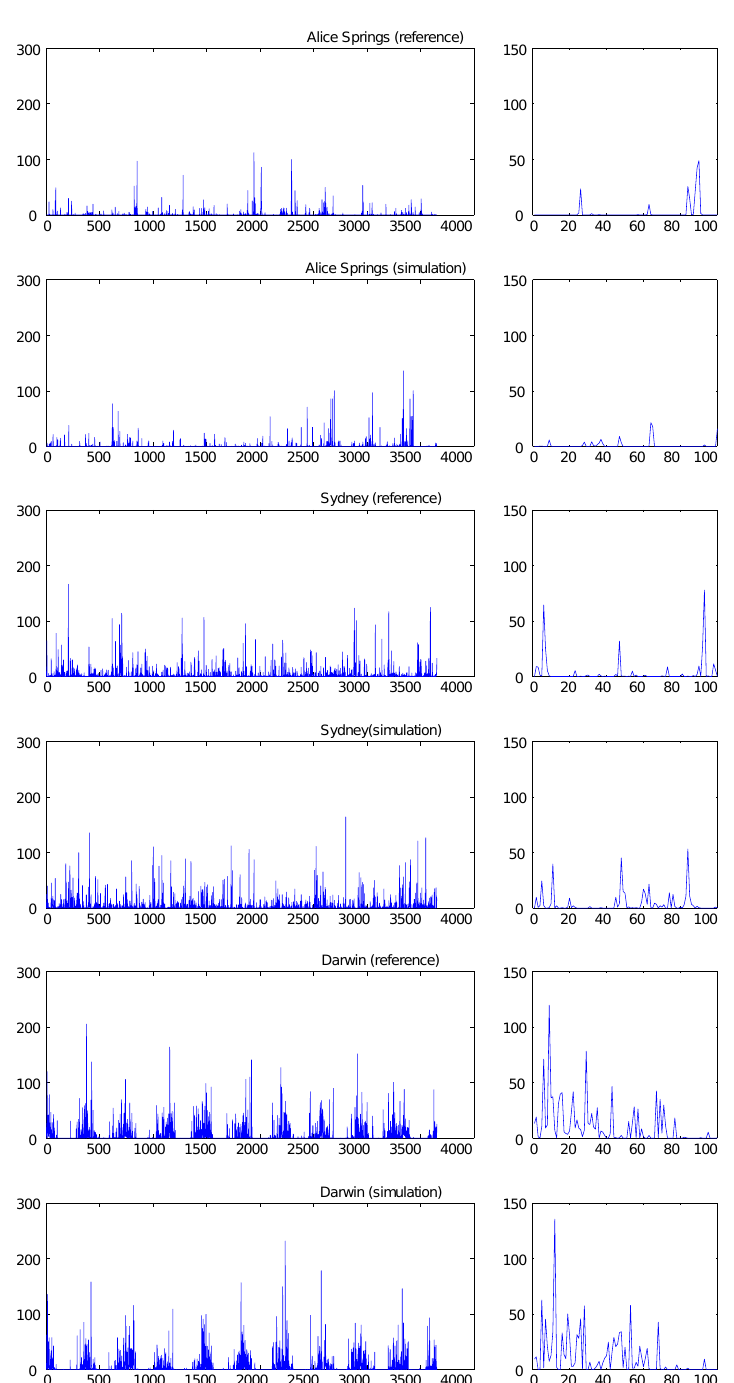
Figure 2. Visual comparison between the simulated and the reference daily rainfall (mm) time series: 10-year (left-column panels) and 100-day (right-column panels) random Fig. 2. Visual comparison between the simulated and the reference daily rainfall [ mm ] time-series: 10-years (left column) and 100-days (right column) random samples.